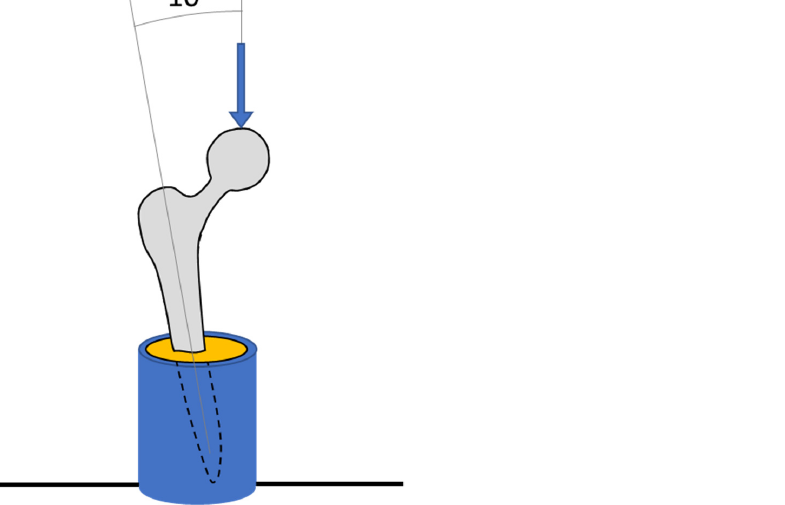
Principal compressive group